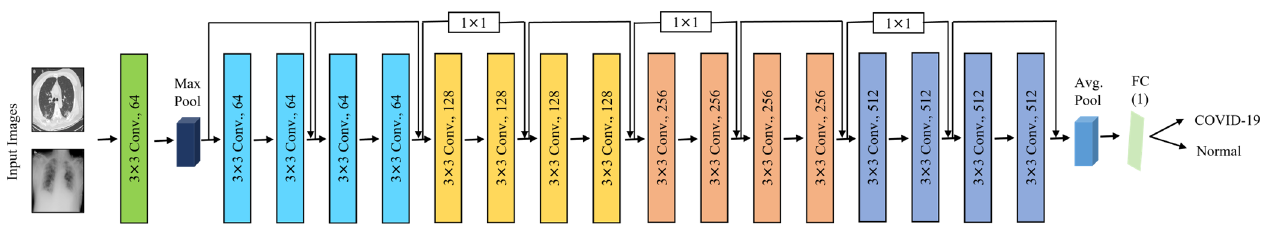
Figure 6. Network architecture of ResNet18 for COVID-19 detection.